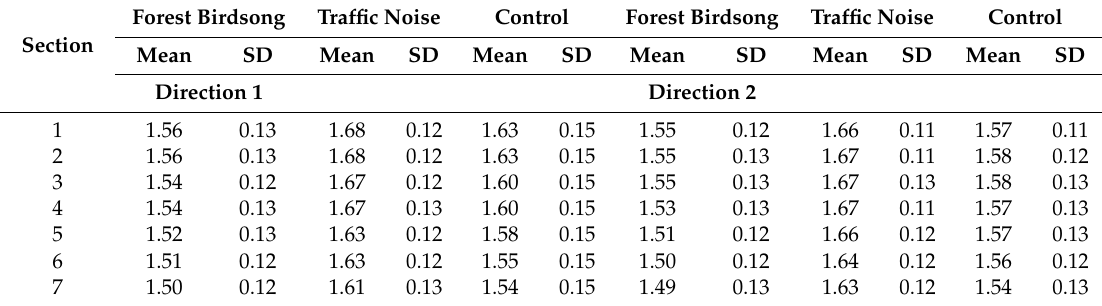
Table 2. The average walking speeds (m/s) in specific sections of the route for the two experimental conditions (forest birdsong, traffic noise), and the control condition for both directions of the walk. Direction 1 is from section 1 to section 7, and direction 2 is from section 7 to section